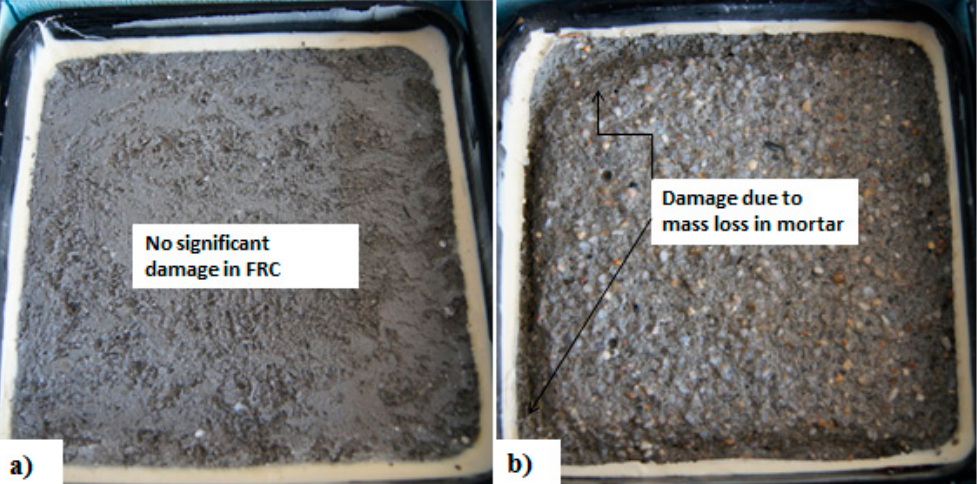
Figure 7. Damage on the surface of ( a ) FRC with PVA fiber and ( b ) high strength mortar specimen after 28 freeze-thaw cycles.